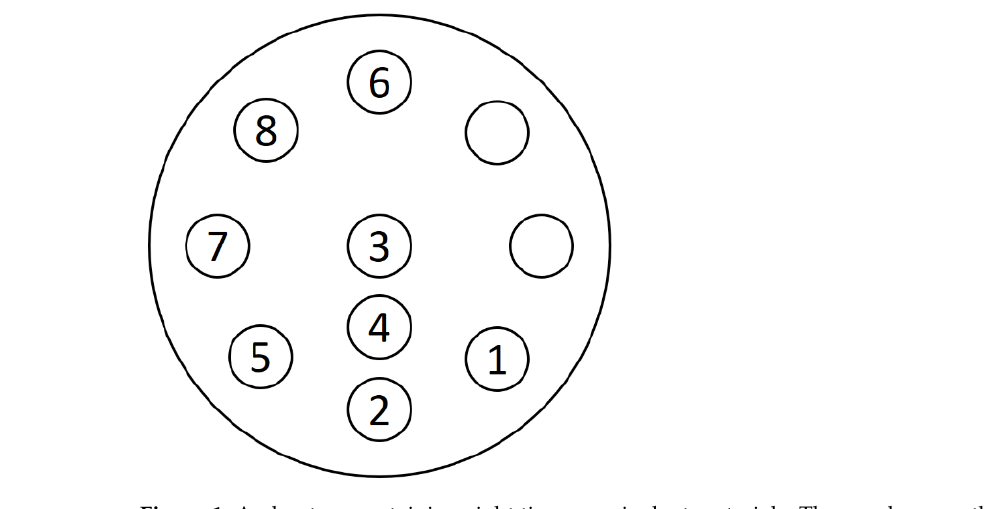
Figure 1. A phantom containing eight tissue-equivalent materials. The numbers are the same as the substances in Table 1. Table 1. Eight materials for stoichiometric calibration, the type of material, relative electron density, and effective atomic number are described.